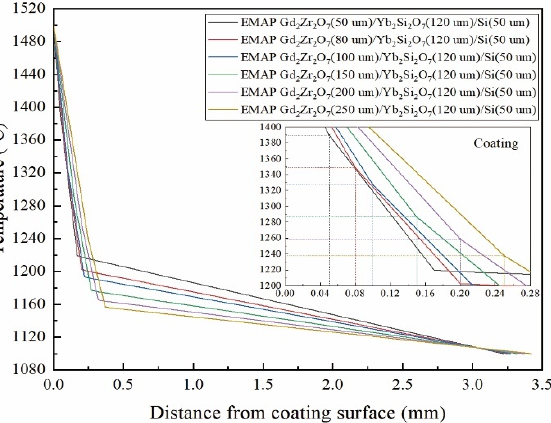
Figure 9. Temperature distributions of EGYS coating system at different thicknesses of EMAP Gd 2 Zr 2 O 7 layer (h = 50, 80, 100, 150, 200, and 250 μ m) during heat preservation period.